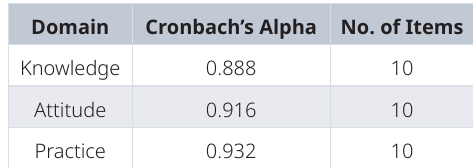
Table 4. Cronbach’s Alpha coefficient values indicating the internal consistency of questionnaire items.